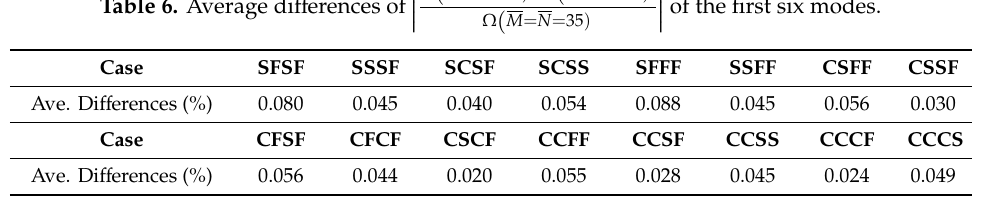
Table 6. Average di ff erences of